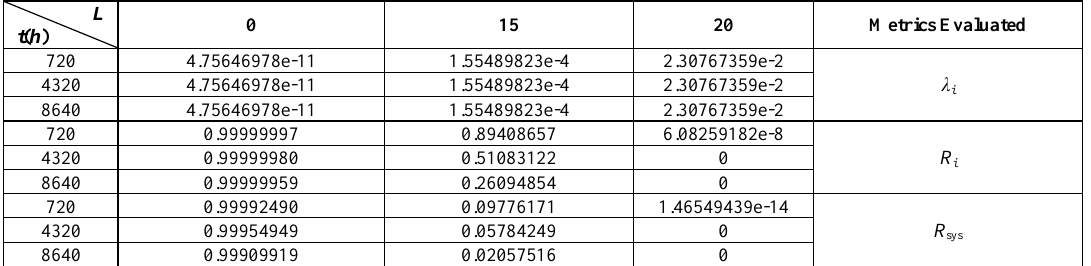
Table 5 . Switch failure rate ( λ i ) and reliability ( R i ), and SAN reliability ( R sys ) for α i = 1.